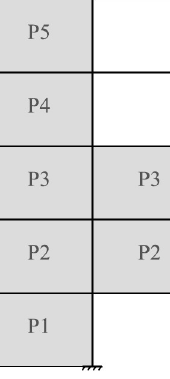
Figure 7. Best configuration of SPSW3-5.